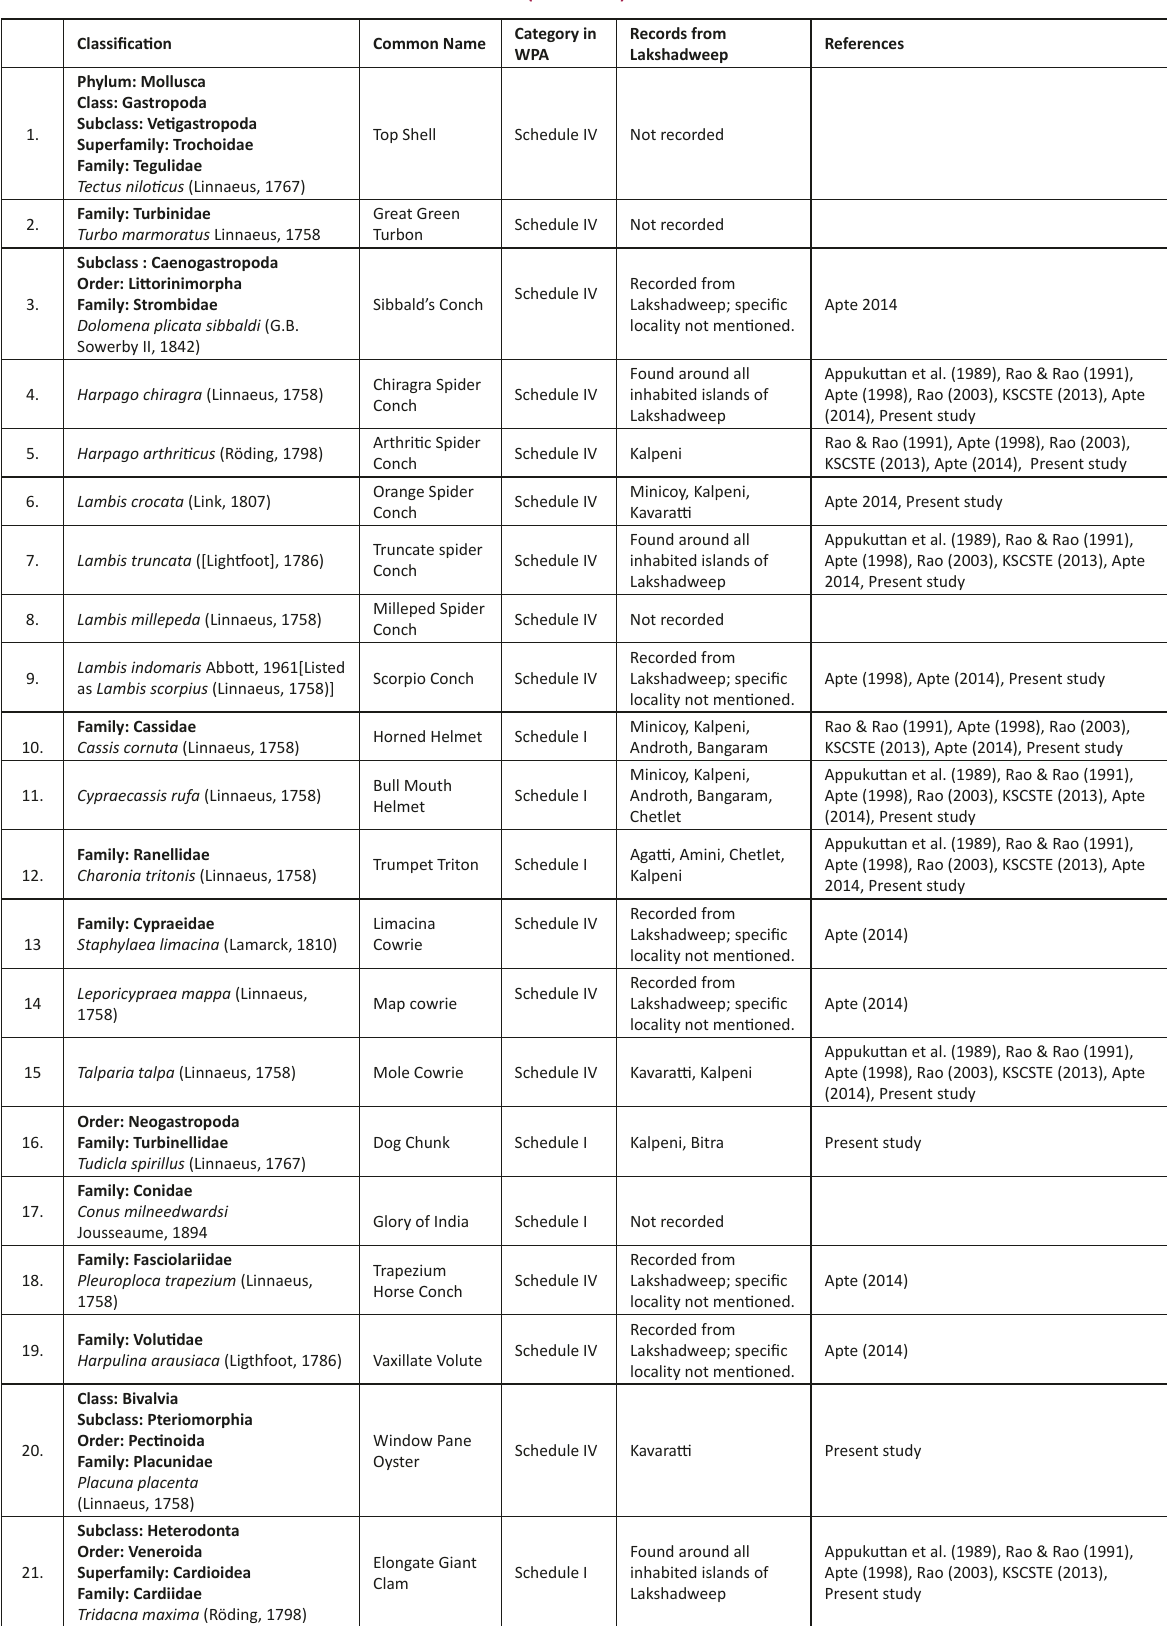
Table 1. List of marine molluscs in various Schedules of Wildlife (Protection) Act of